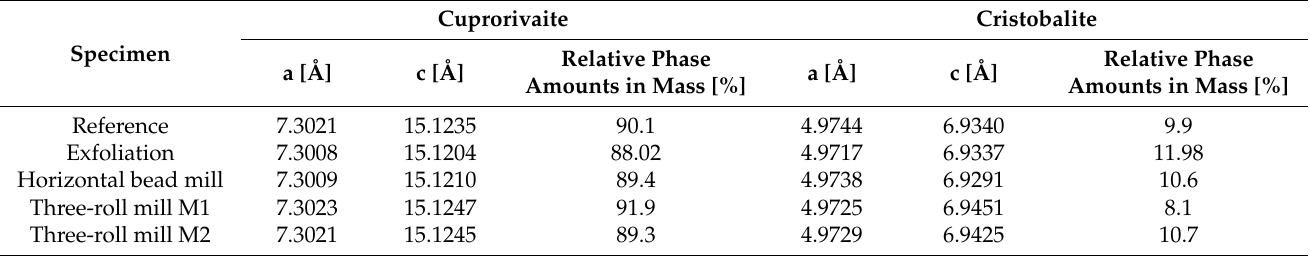
Table 1. Cuprorivaite and cristobalite lattice parameters and relative phase amount with respect to dispersion method.